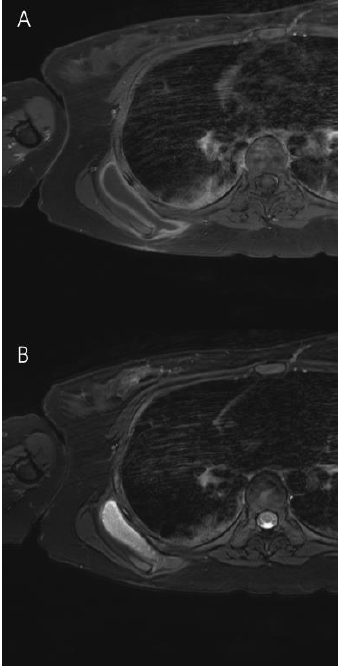
Figure 4. Right shoulder enhanced magnetic resonance imaging showing recurrent bursitis (10.0 cm × 8.0 cm × 2.0 cm) in the right posterolateral chest wall. ( A ) Contrast-enhanced T1-weighted axial view. ( B ) Fat-suppressed contrast-enhanced T2-weighted axial view.